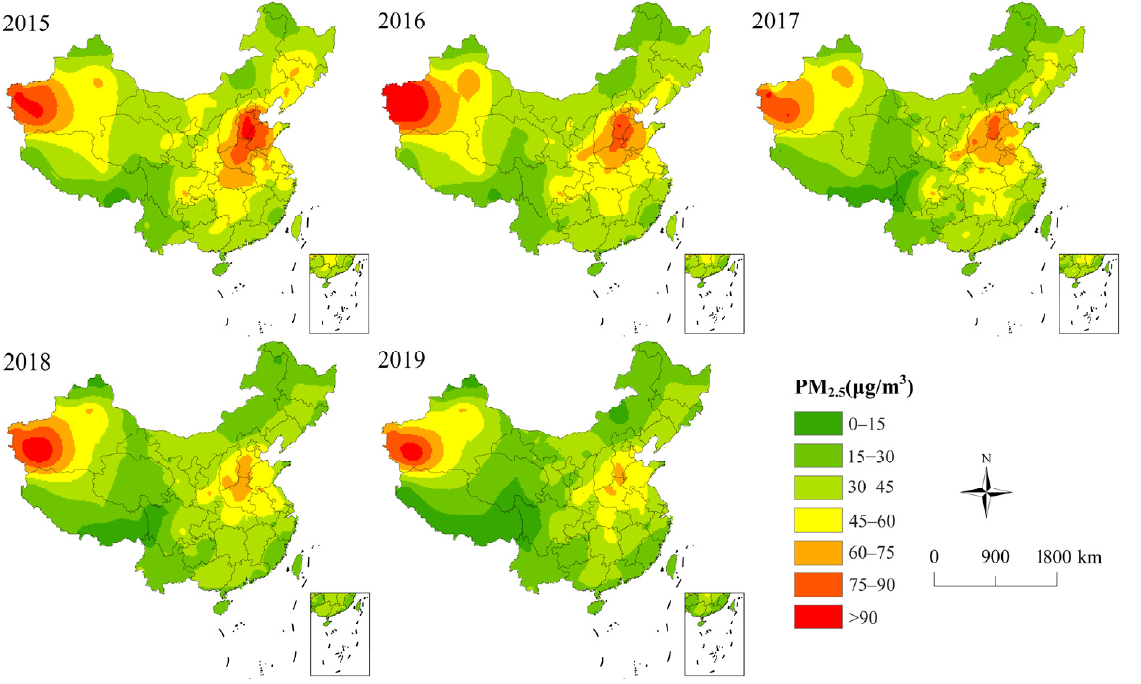
Figure 2. Spatial changes of PM 2.5 in China between 2015 and 2019.